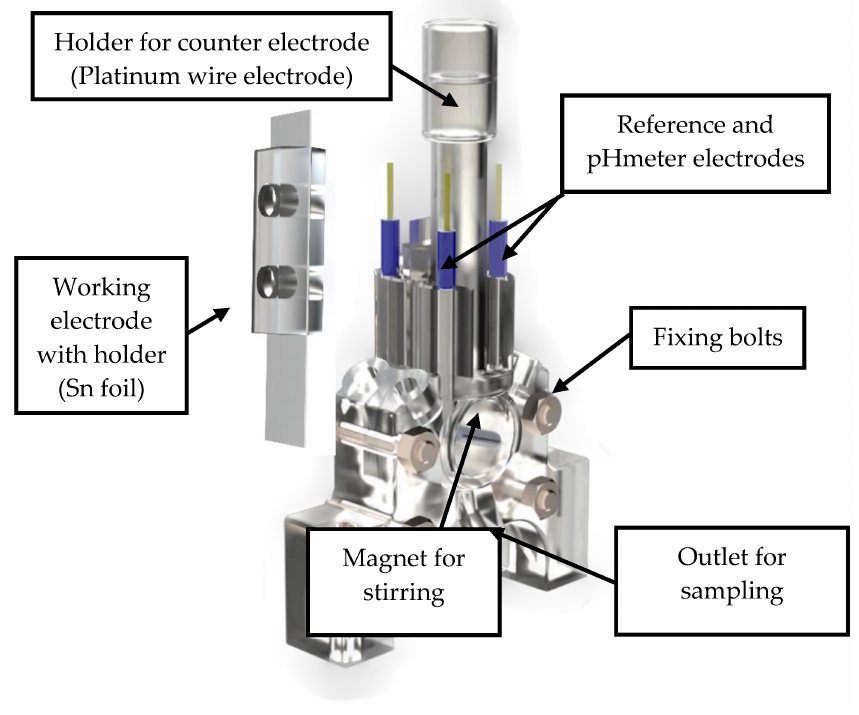
Figure 1 . General view of the rendered 3D design of the final prototype of the reactor.